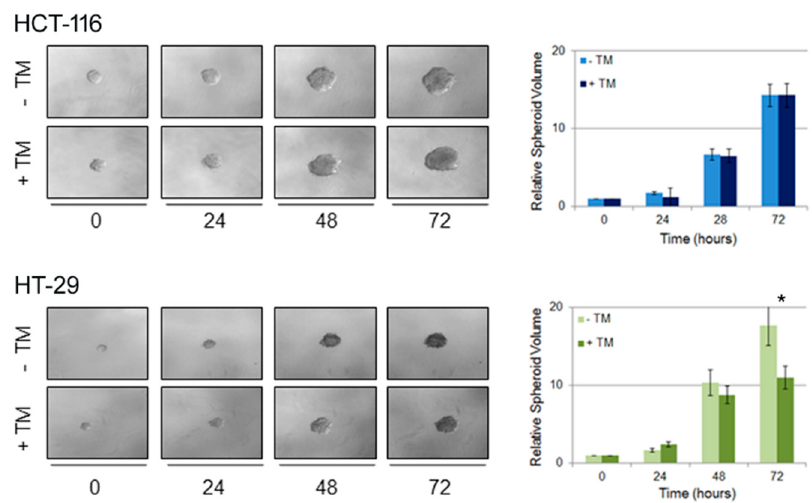
Figure 4. Copper chelation di ff erently a ff ects 3D proliferation of tumor colon cancer spheroids bearing the BRAF V600E mutation. Colon cancer cell lines BRAF wt (HCT-116) and BRAF V600E (HT-29) were seeded on ultra-low attachment dish allowing for tumor spheroid formation. Four days later, spheroids were embedded into Matrigel and then treated with TM 10 µ M. Tumor spheroid formation was assessed at di ff erent time points thereafter and spheroids volume was quantified according to the formula: V = a × (b 2 ) / 2, where a and b are spheroid length and width, respectively. Representative images of spheroids derived from both cell lines are shown in the left panels. Spheroid volume are reported on the right panels. Results are expressed as means ± S.D. of three independent experiments. * ( p < 0.05) TM-treated cells values with respect to untreated